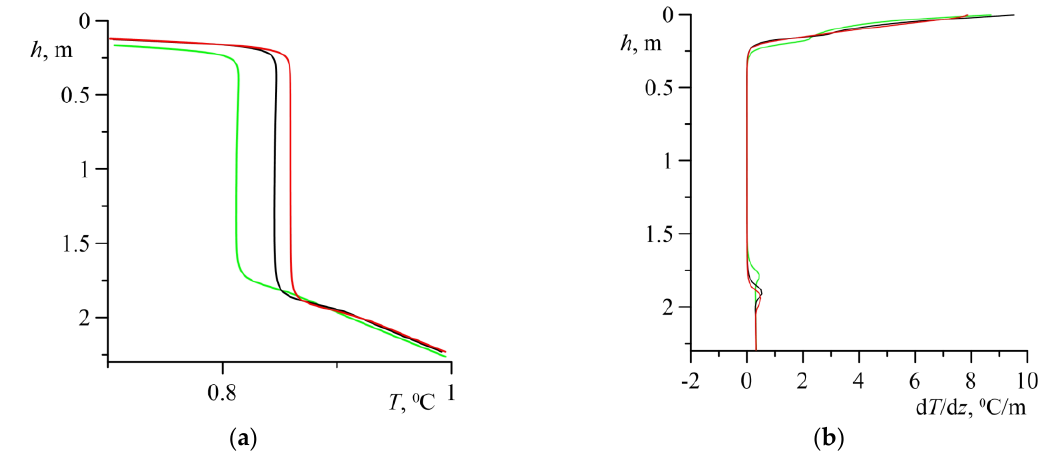
Figure 7. ( a ) Horizontally averaged temperature profiles for Variant 2 at different hours of the 5th day: green curves are 12 p.m., black — 3 p.m., red — 6 p.m. ( b ) Profiles of the averaged temperature gradients at the same time moments.